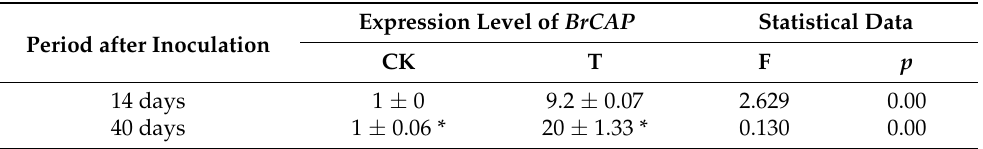
Table 4. Statistical data of the expression level of BrCAP between inoculated treatment with P. brassicae and un-inoculated control at different infection